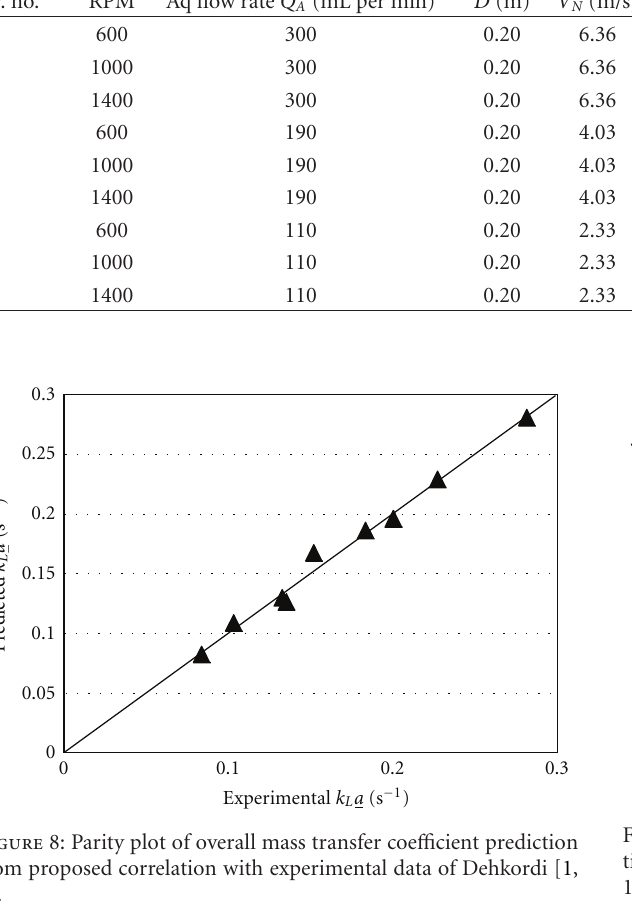
phenomena are governed by small-scale eddies, and drop size is controlled by the shear in extractor volume. The understanding gained from the single phase CFD simulation can give very useful insights into two-phase extraction processes. CFD simulations clearly bring out the fact that the extractor e ffi ciency is strongly dependent on the jet velocity and rotation speed of the upper disc. However, the e ff ect of change of the disc diameter is not